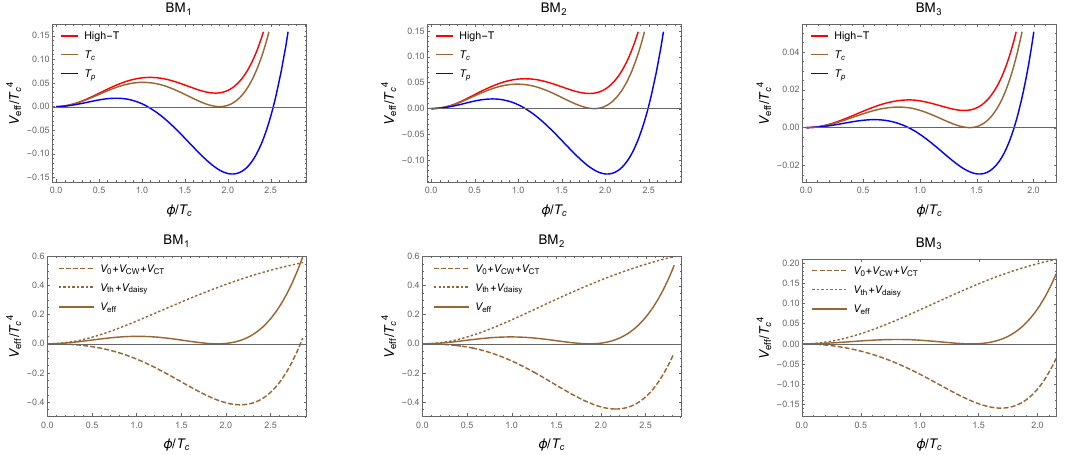
Figure 1 . Top: evolution of the vacuum for three benchmark points on the V eff /T 4 The three temperatures are, respectively, some temperature higher than T temperature T (brown), and the percolation temperature T c section 4; Bottom: components of the effective potential at T